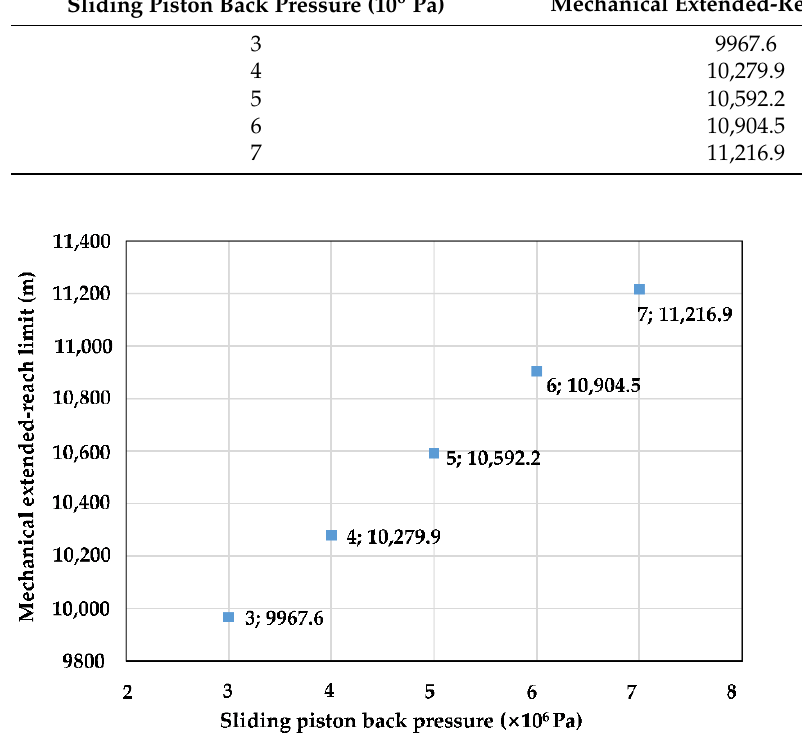
Figure 7. Effect of the sliding piston back pressure on the mechanical extended-reach limit.